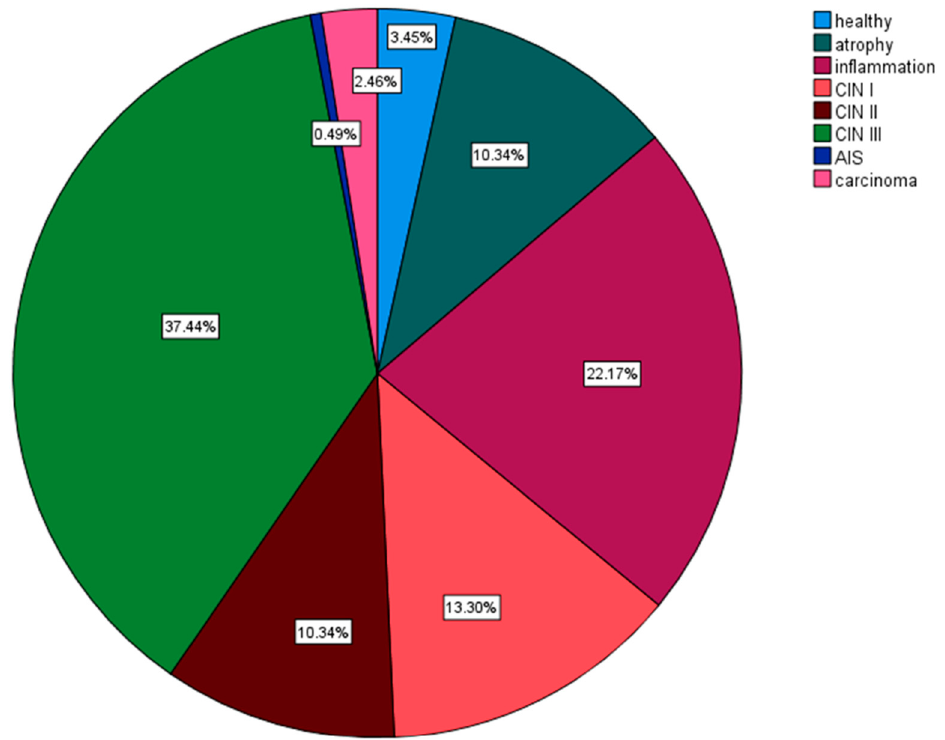
Figure 2. Histopathological outcome.